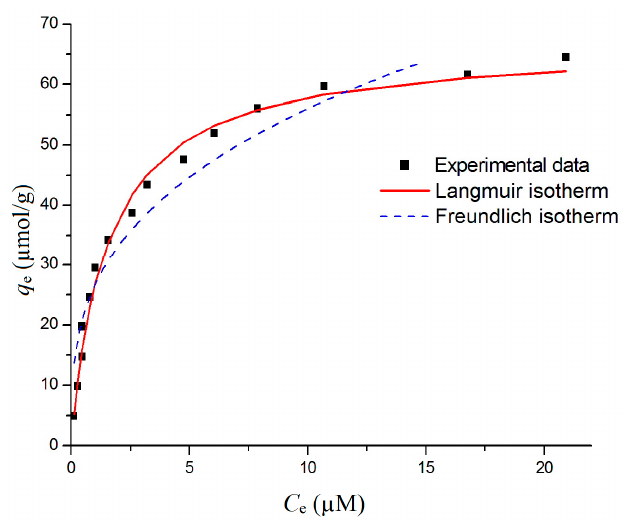
Figure 6. Langmuir and Freundlich isotherms for Cr(VI) adsorption on goethite. Table 2. Parameters calculated for Langmuir and Freundlich models.